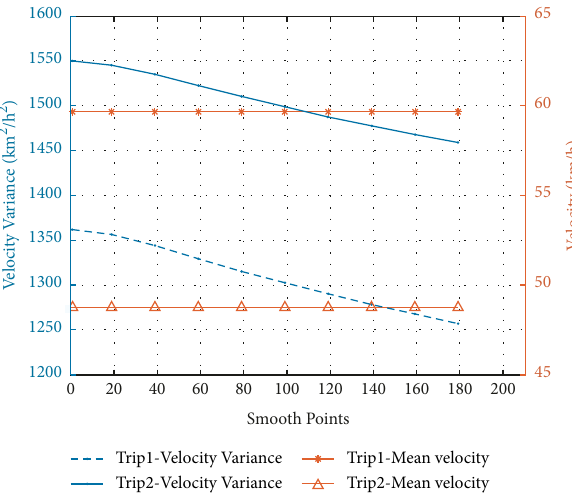
Figure 7: Statistical characteristics of the cycles for Trip 1 and Trip 2 with different filters.